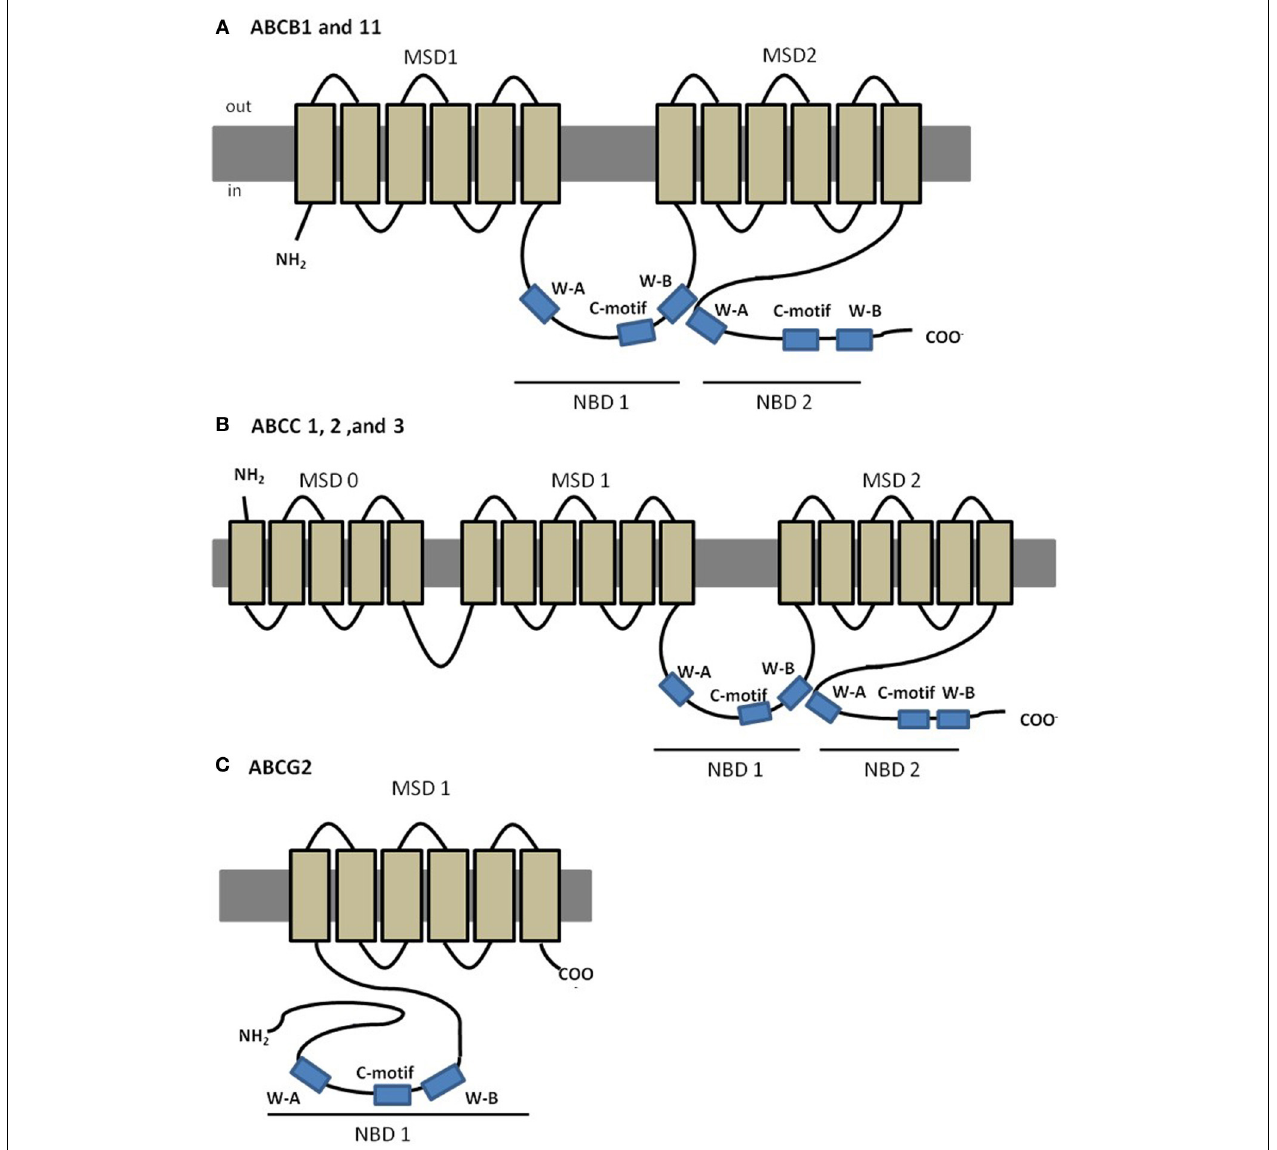
FIGURE 2 | Predicted structures of MDR associated members of ABC transporters. (A) Predicted structure of ABCB1 and ABCB11; (B) predicted structure of “long-chain” ABCC proteins, ABCC1, 2 and 3; (C) predicted structure of